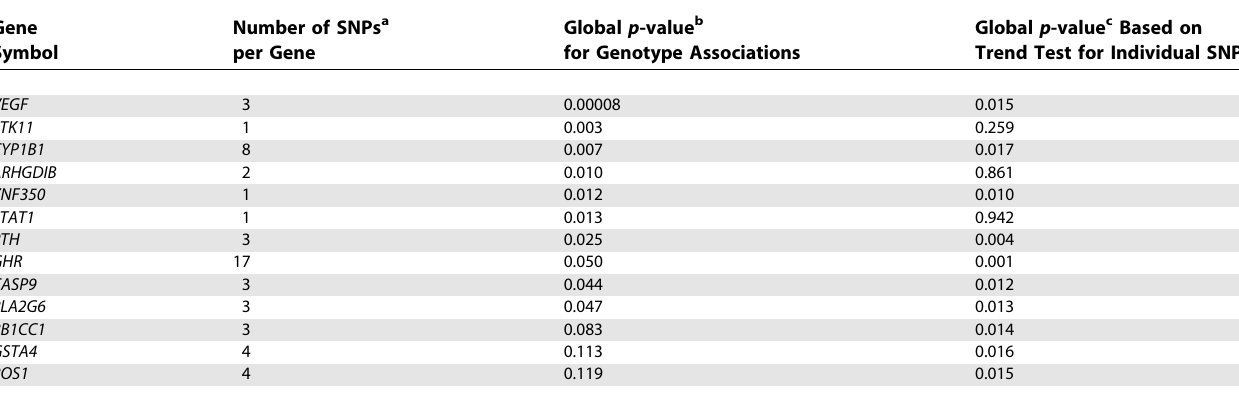
VEGF: Vascular endothelial growth factor; STK11: Serine/threonine kinase 11; CYP1B1: Cytochrome P450, family 1, subfamily B, polypeptide 1; ARHGDIB: Rho GDP dissociation inhibitor (GDI) beta; ZNF350: Zinc finger protein 350; STAT1: Signal transducer and activator of transcription 1, 91kDa; PTH: Parathyroid hormone receptor 1; GHR: Growth hormone receptor; CASP9: Caspase 9, apoptosis-related cysteine peptidase; PLA2G6: phospholipase A2, group VI ; RB1CC1: RB1-inducible coiled-coil 1; GSTA4: glutathione S-transferase A4; ROS1: v-ros UR2 sarcoma virus oncogene homolog 1